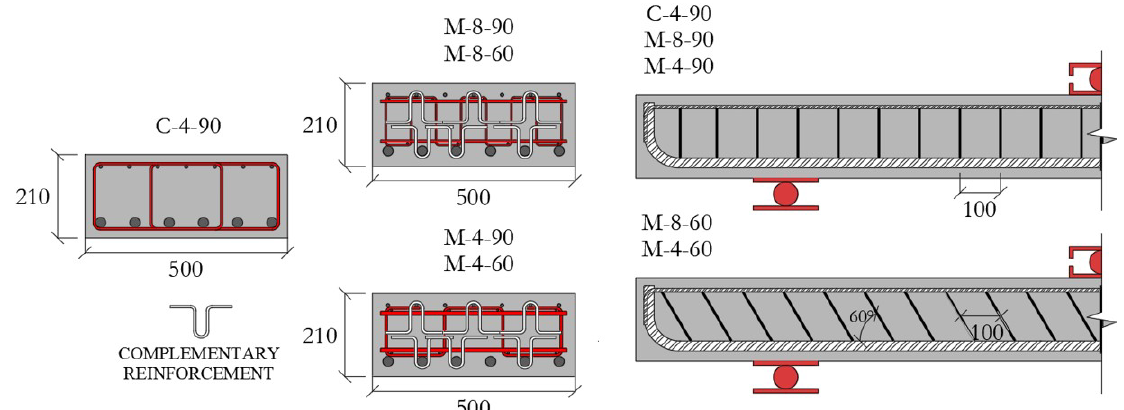
Figure 4 - Cross section and reinforcement layout of the tested beams.